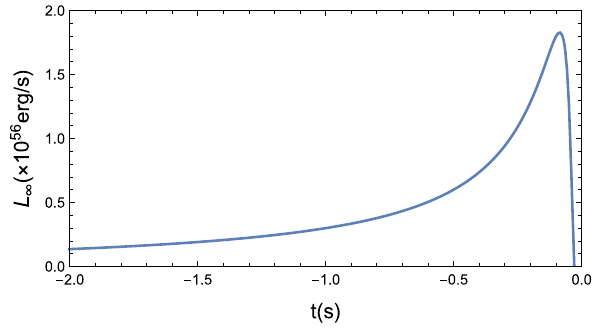
Fig. 4 Luminosity at infinity